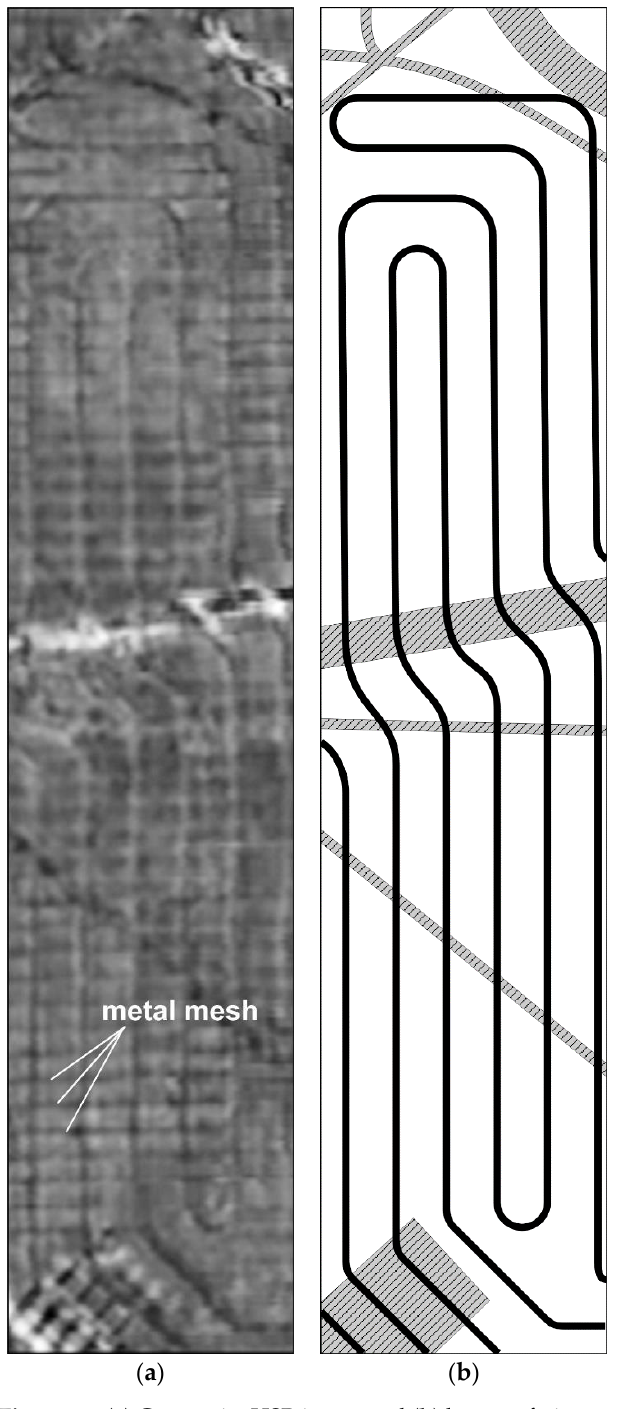
Figure 28. ( a ) Composite HSR image and ( b ) layout of pipes and cables.